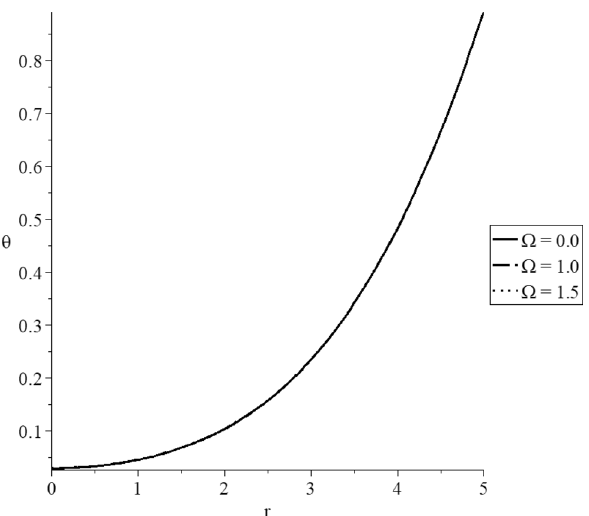
Figure 16. The dynamical temperature increment distribution with various values of the angular velocity of the rotation